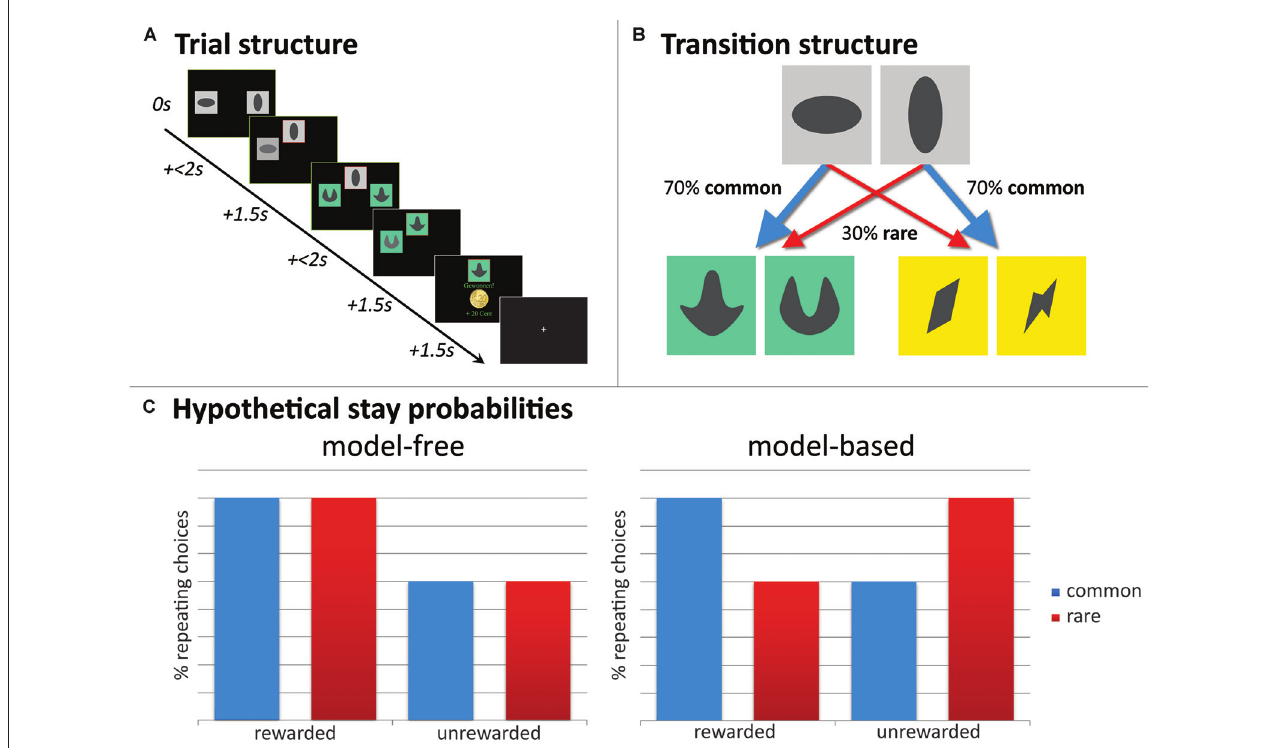
FIGURE 2 | Experimental paradigm, two-step sequential decision-making task. (A) Example of a trial-sequence with timing; (B) state-transition probabilities indicating common and rare transitions; (C) hypothetical full model-free (MF) and full model-based (MB) choice strategies would result in these choice patterns. Depicted here, stay probability plots for first step choices as a function of reward (reward vs. no reward) and state (common vs. rare). A main effect of reward guides MF choice strategies, whereas MB choice strategies show a reward ∗ state interaction.